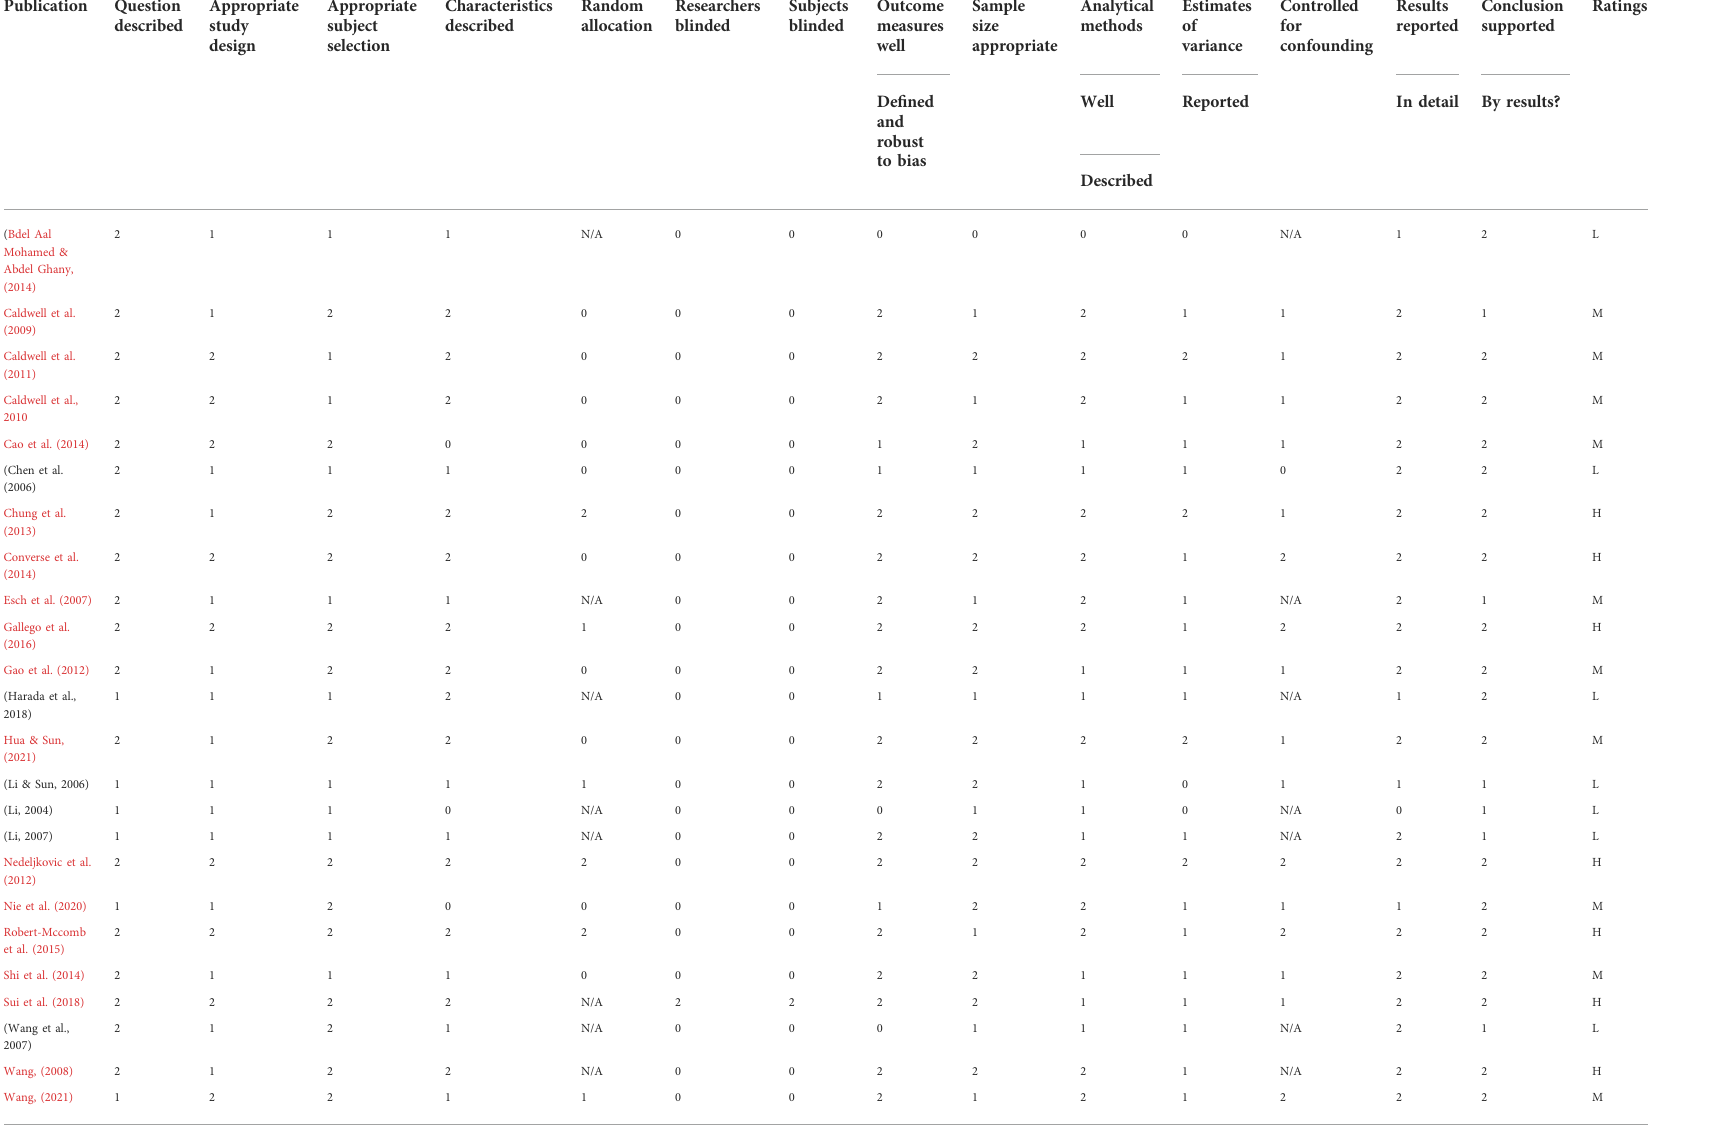
TABLE 3 “ Qualsyst ” of quality